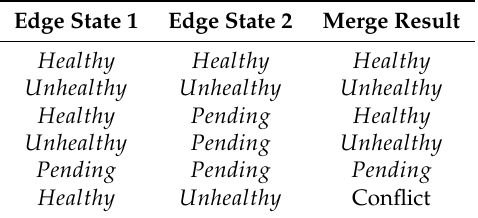
Table 4. Edge merging